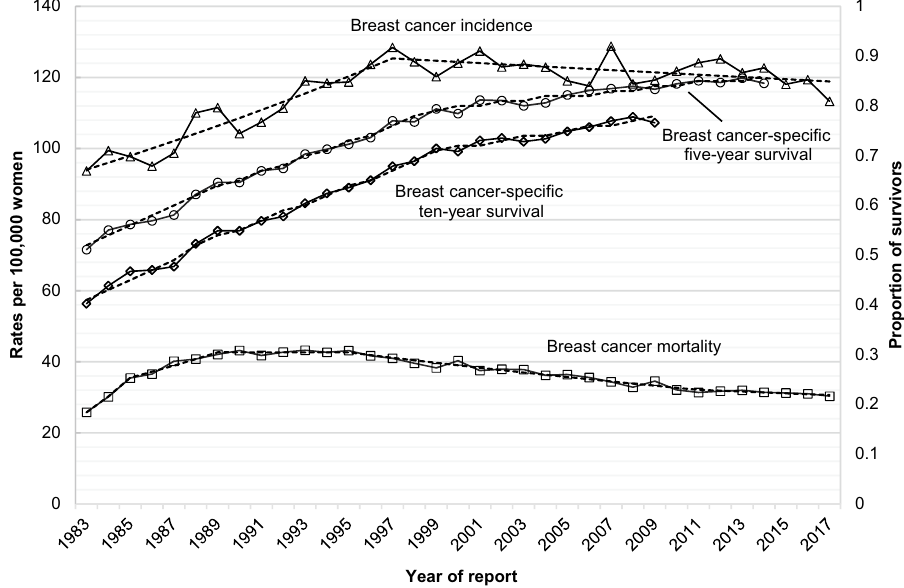
Figure 1. Overall incidence, breast cancer-specific mortality, and breast cancer-specific survival in women in Austria according to year of diagnosis, 1983–2017 (age-standardised, European Standard Population 2013). Dashed lines indicate joinpoint regression estimates.